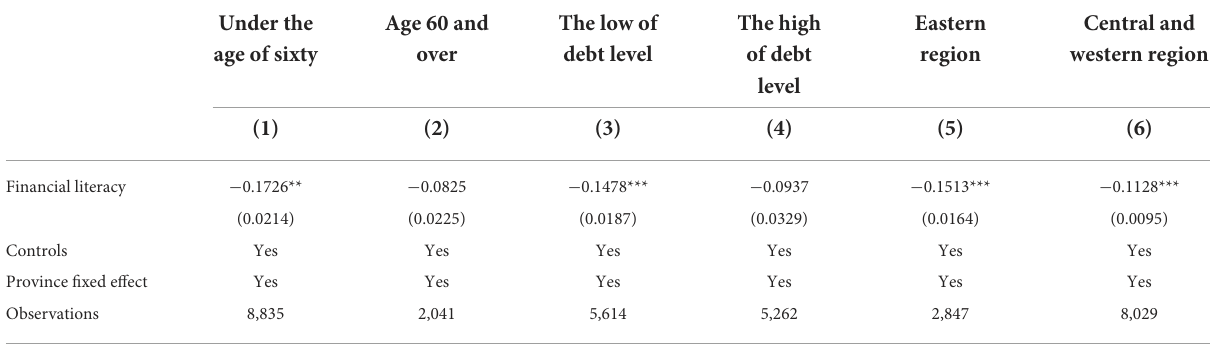
TABLE 11 Heterogeneity analysis: different households characteristics and regional